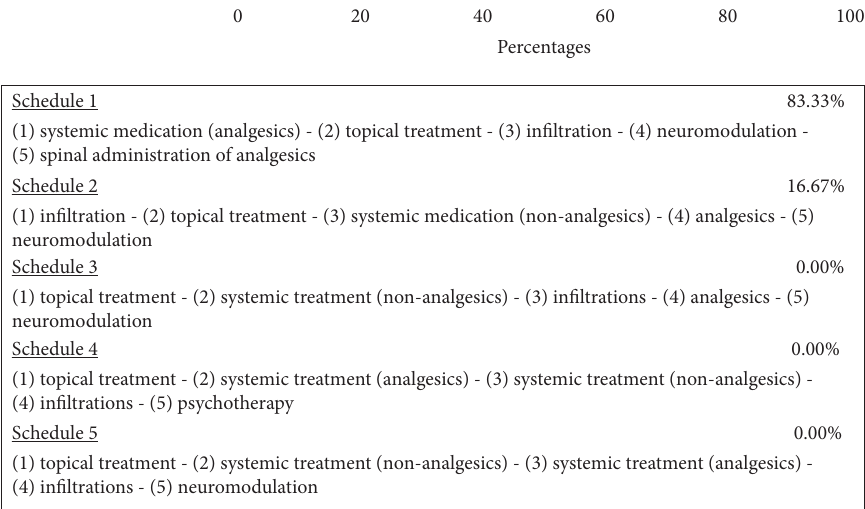
Figure 2: Diferent fowcharts that were evaluated in the survey as possible frst-choice treatment approaches for localized neuropathic pain conditions within Belgian multidisciplinary pain centers. Topical treatment options are never considered as a frst-line treatment in these